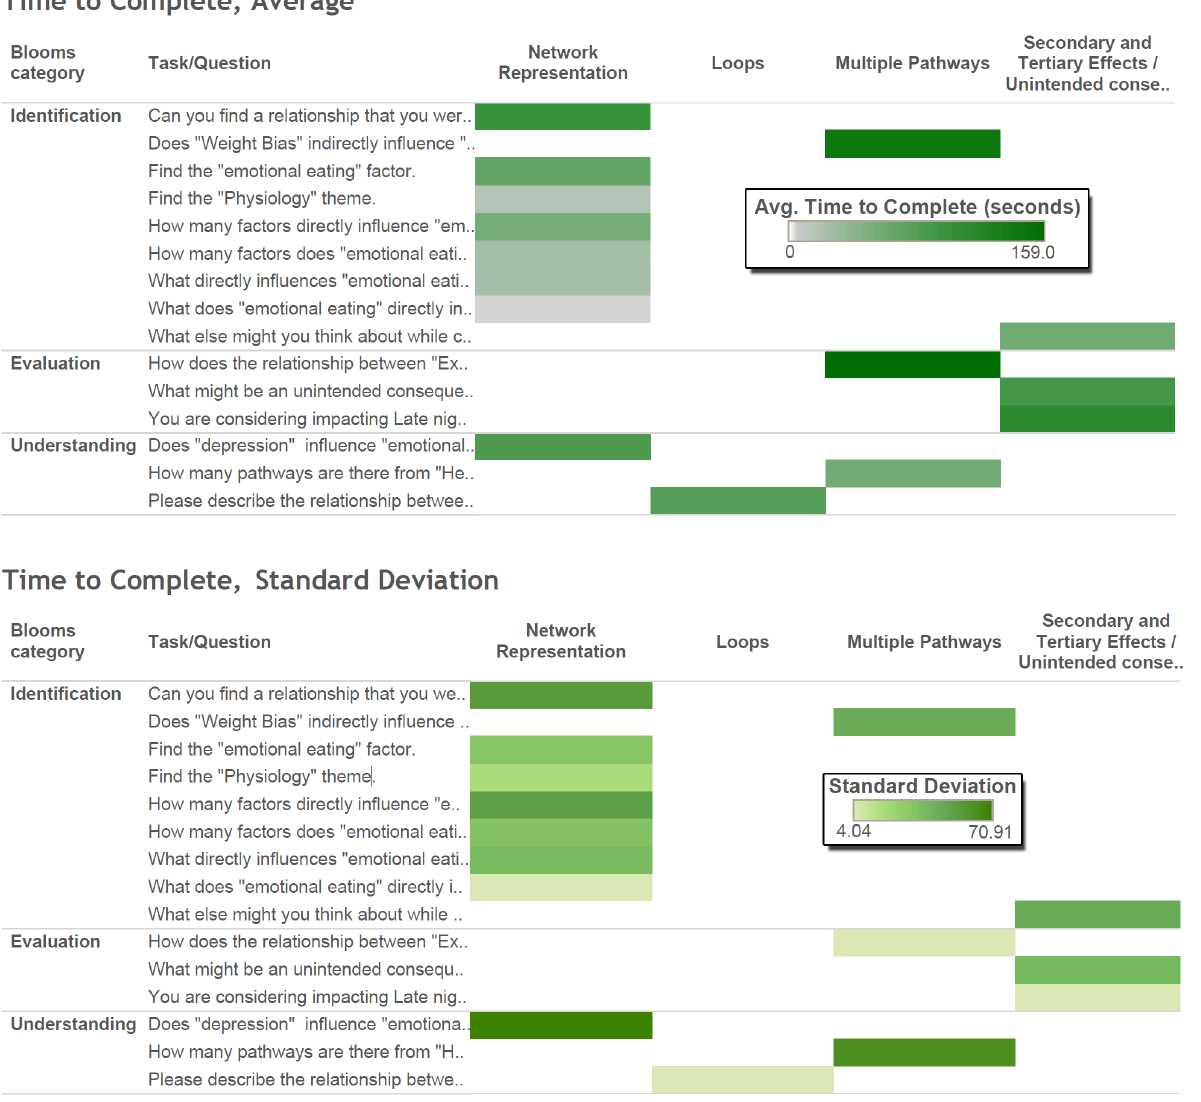
Figure 10. Average time to completion ( top ) and standard deviation ( bottom ) across all users.